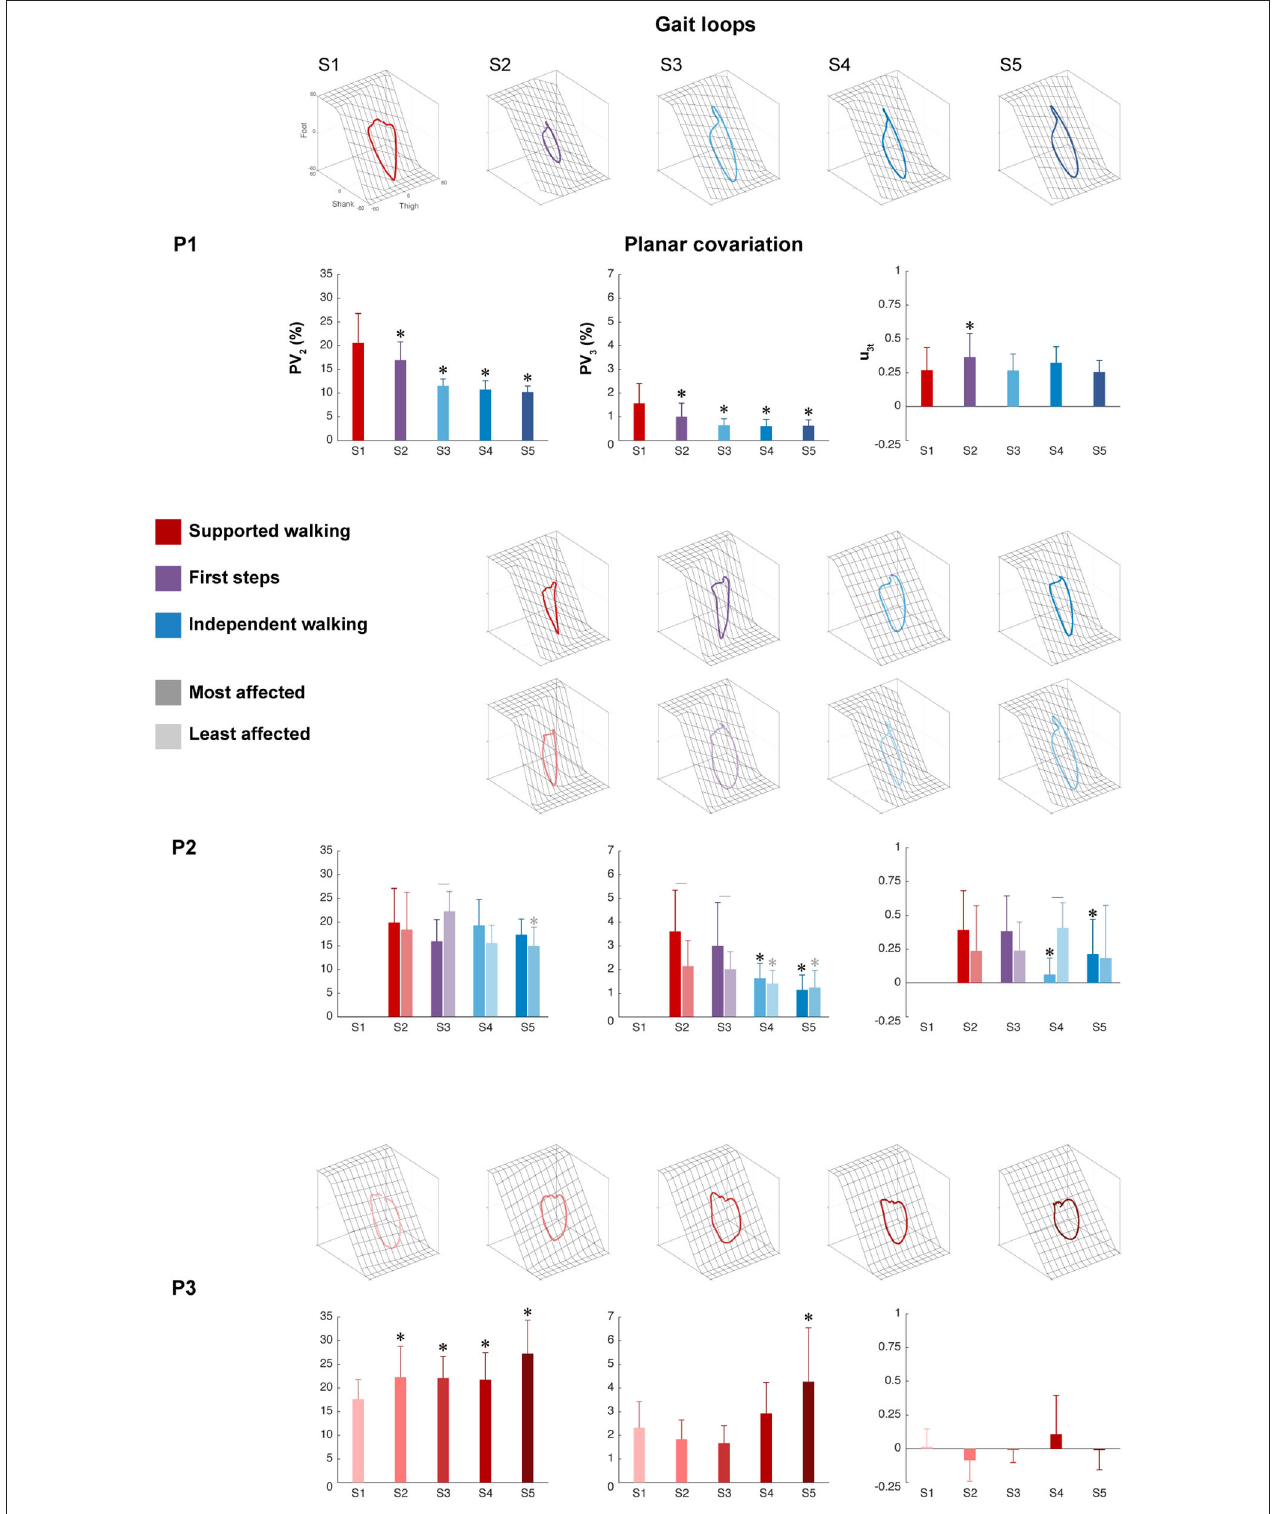
FIGURE 3 | Intersegmental coordination. Gait loops plus the corresponding mean percentage of total variance explained by the second and third eigenvectors (PV 2 and PV 3 ), and the mean orientations of the normal to the plane (u 3t ) are shown from S1 to S5 for each participant. Error bars indicate SDs across strides. For P2, the most affected side (dark color) and the least affected sides (light color) are shown, whereas for P1 and P3, one side is shown. Significant differences with session 1 are marked by asterisks, and significant interactions between session and side are denoted by lines between the most and least affected sides for P2 ( p < 0.05).